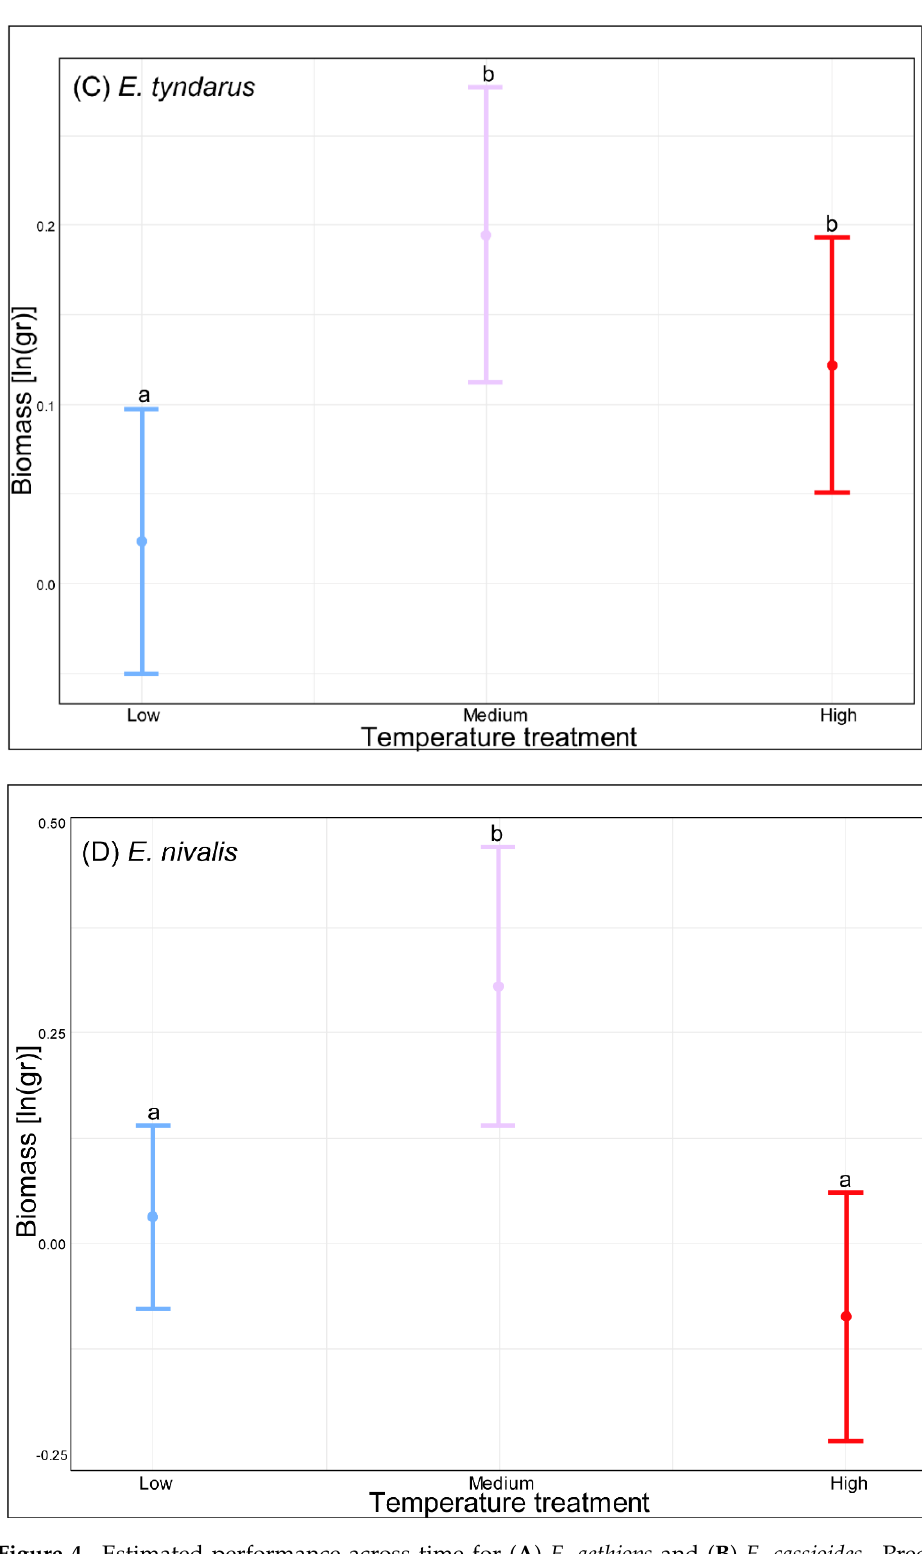
Figure 4. Estimated performance across time for ( A ) E. aethiops and ( B ) E. cassioides . Predicted mean values (center point) of biomass and the CI at 95% for the different treatments are plotted for ( C ) E. tyndarus and ( D ) E. nivalis . The different treatments are noted with lowercase letters. Models fitted for individuals that had two or more mass measurements. As we found no difference in the performance of E. manto among temperature treatments, the species is not illustrated.